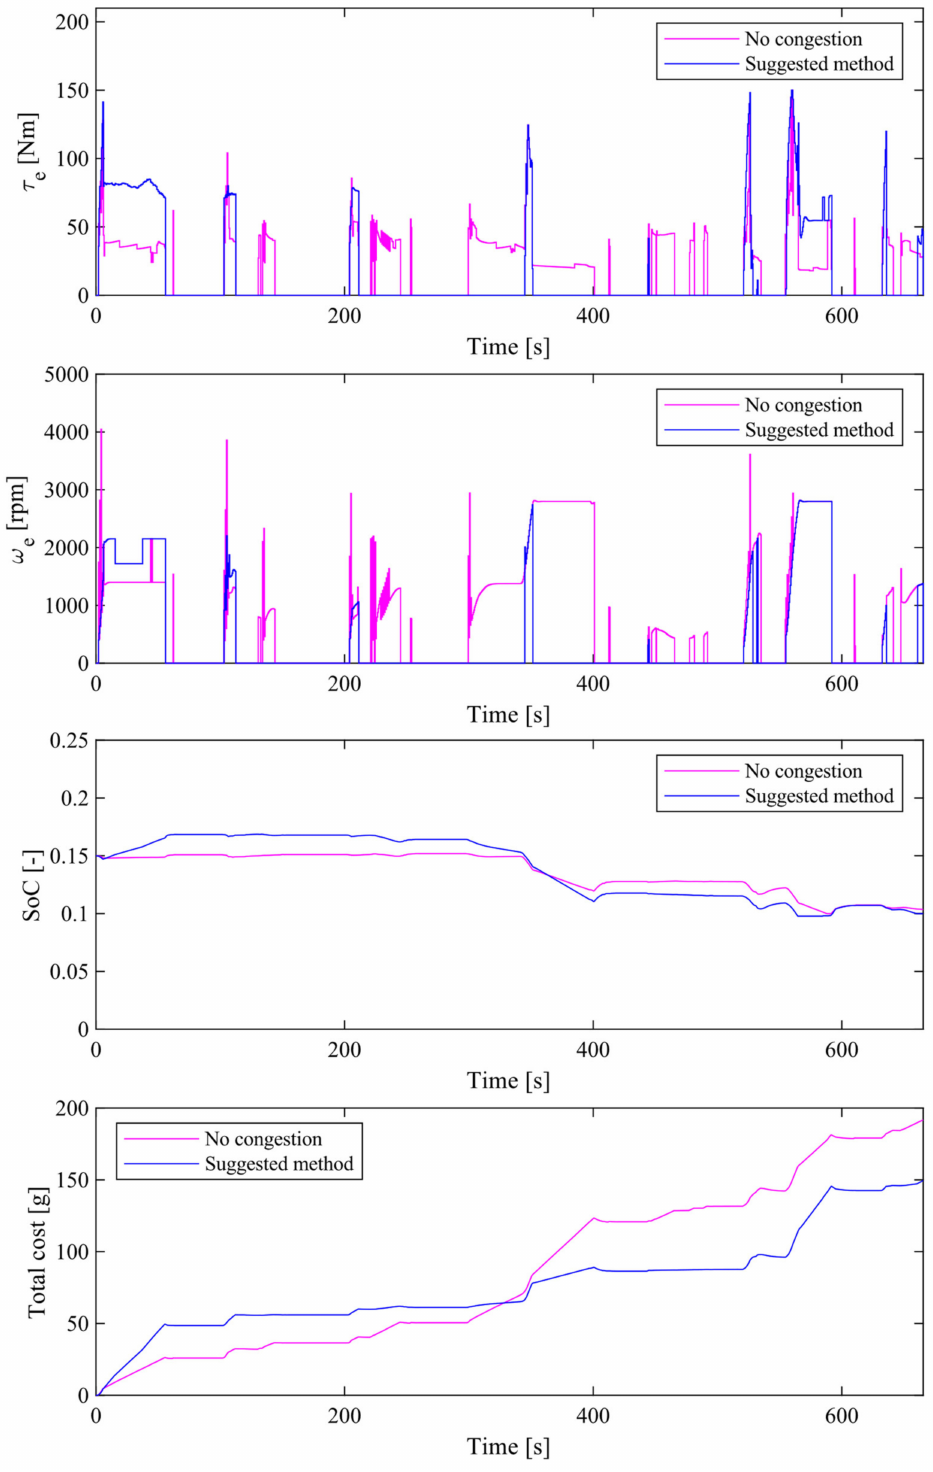
Figure 12. Simulation results of the proposed method and without the traffic congestion vector for the test data on Road A (engine torque, engine speed, SoC , and total